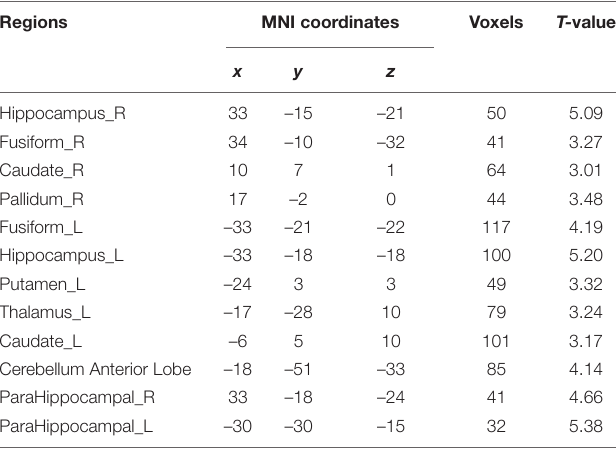
TABLE 3 | Brain regions with altered zALFF in patients with